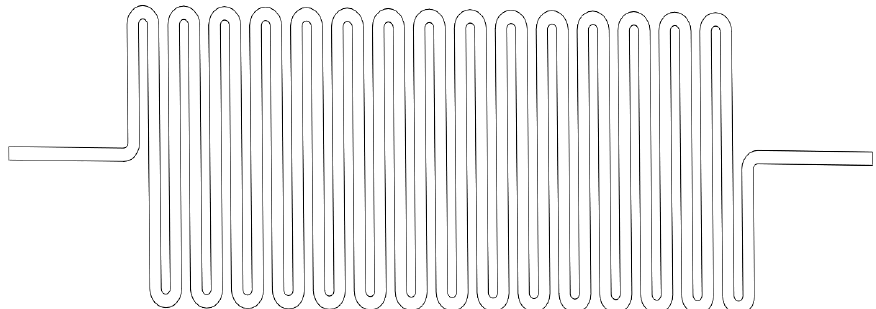
Figure A12. Fabric Design XSP-3. Large single pass design, woven conductive polyester fabric.